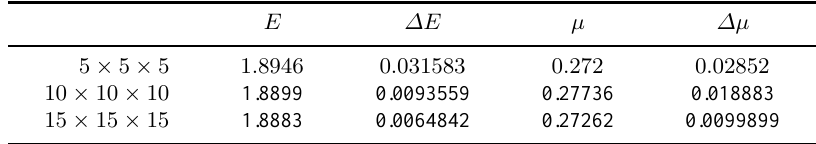
Table 2. Mean values of elastic